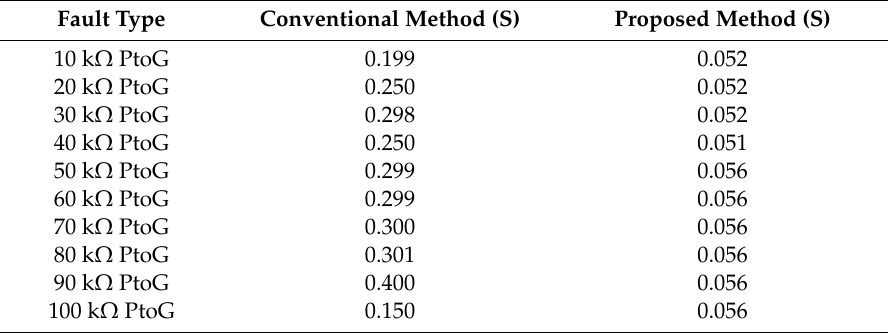
Table 2. The comparison of the fault detection time between the conventional and the proposed